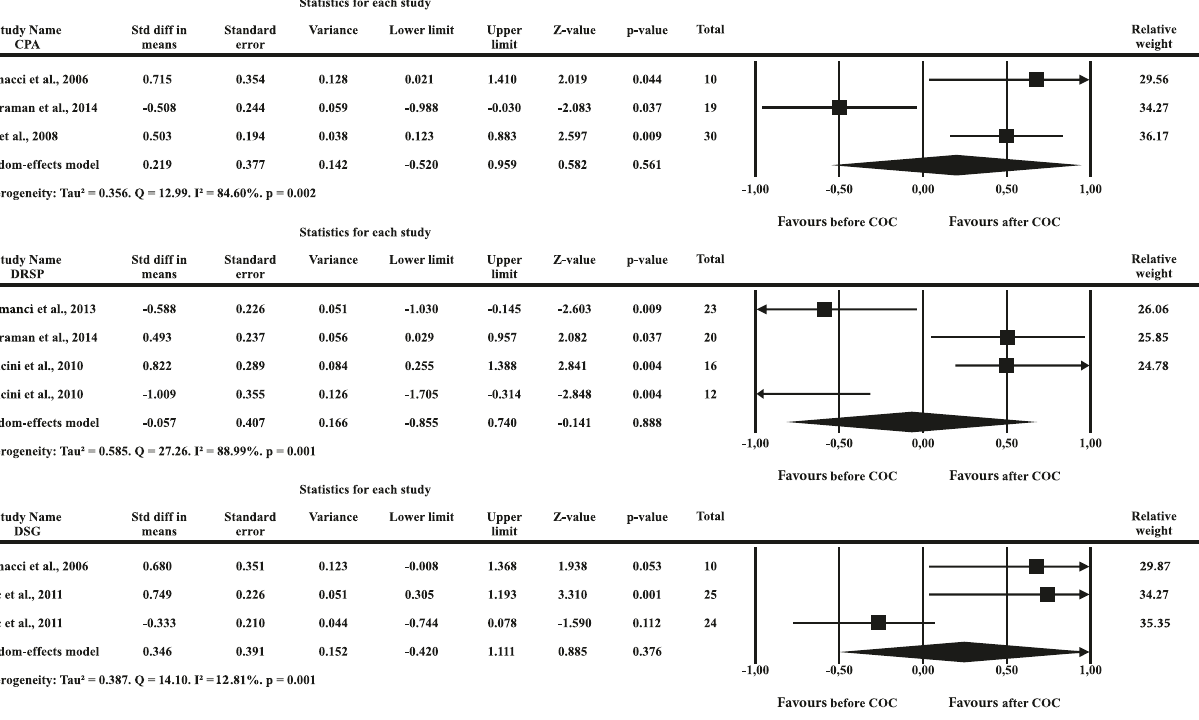
Figure 3: Forest plot of the standardized difference means of homocysteine between before and after the use of combined oral contraceptive in PCOS patients.